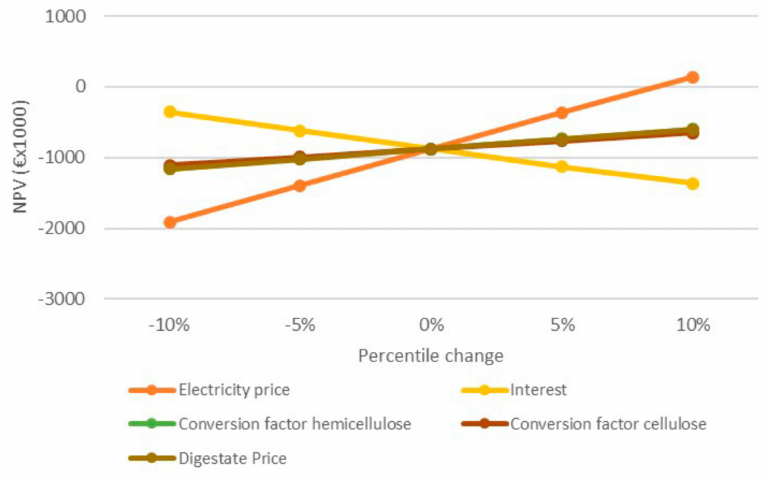
Figure 6. The influence of ± 5% and ± 10% change of the parameters on the profitability of a biogas power plant that uses SBP as feedstock.